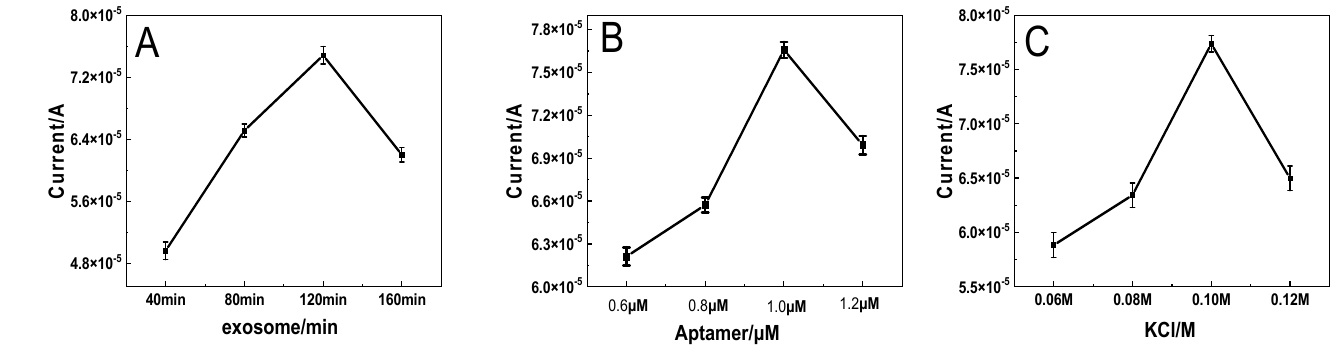
Figure 5. Effect of ( A ) the incubation time, ( B ) the Apt concentration, and ( C ) the concentration of KCL on the DPV response during the detection of exosomes.